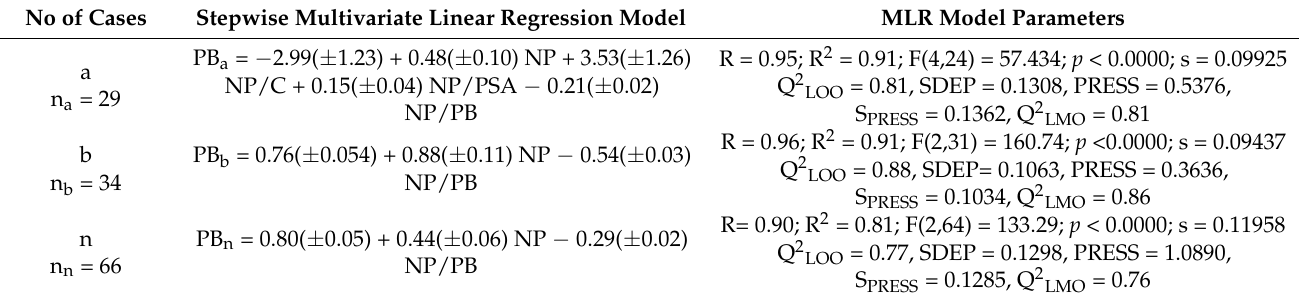
Table 2. MLR models for acidic (a), basic (b) and neutral (n) active pharmaceutical ingredients (APIs) using NP TLC retention data .